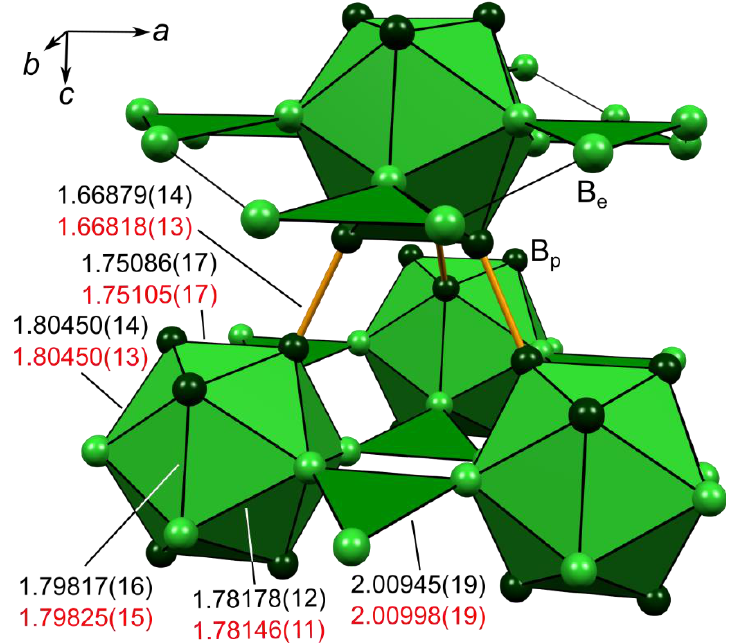
Figure 2. Structural fragment of α-boron, where polar and equatorial boron atoms B p and B e are shown in darker and lighter color, respectively. Apart from delocalized intraicosahedral bonding in the B 12 icosahedra, (2c,2e)-B p -B p bonds are shown as orange sticks and (3c,2e)-B e -B e -B e bonds are shown as green triangles. Bond lengths are specified in Ångström based on the HCM( F exp ) (black numbers, top) and the final aspherical EHCM( F exp ) (red numbers, bottom) refinement presented in this study.